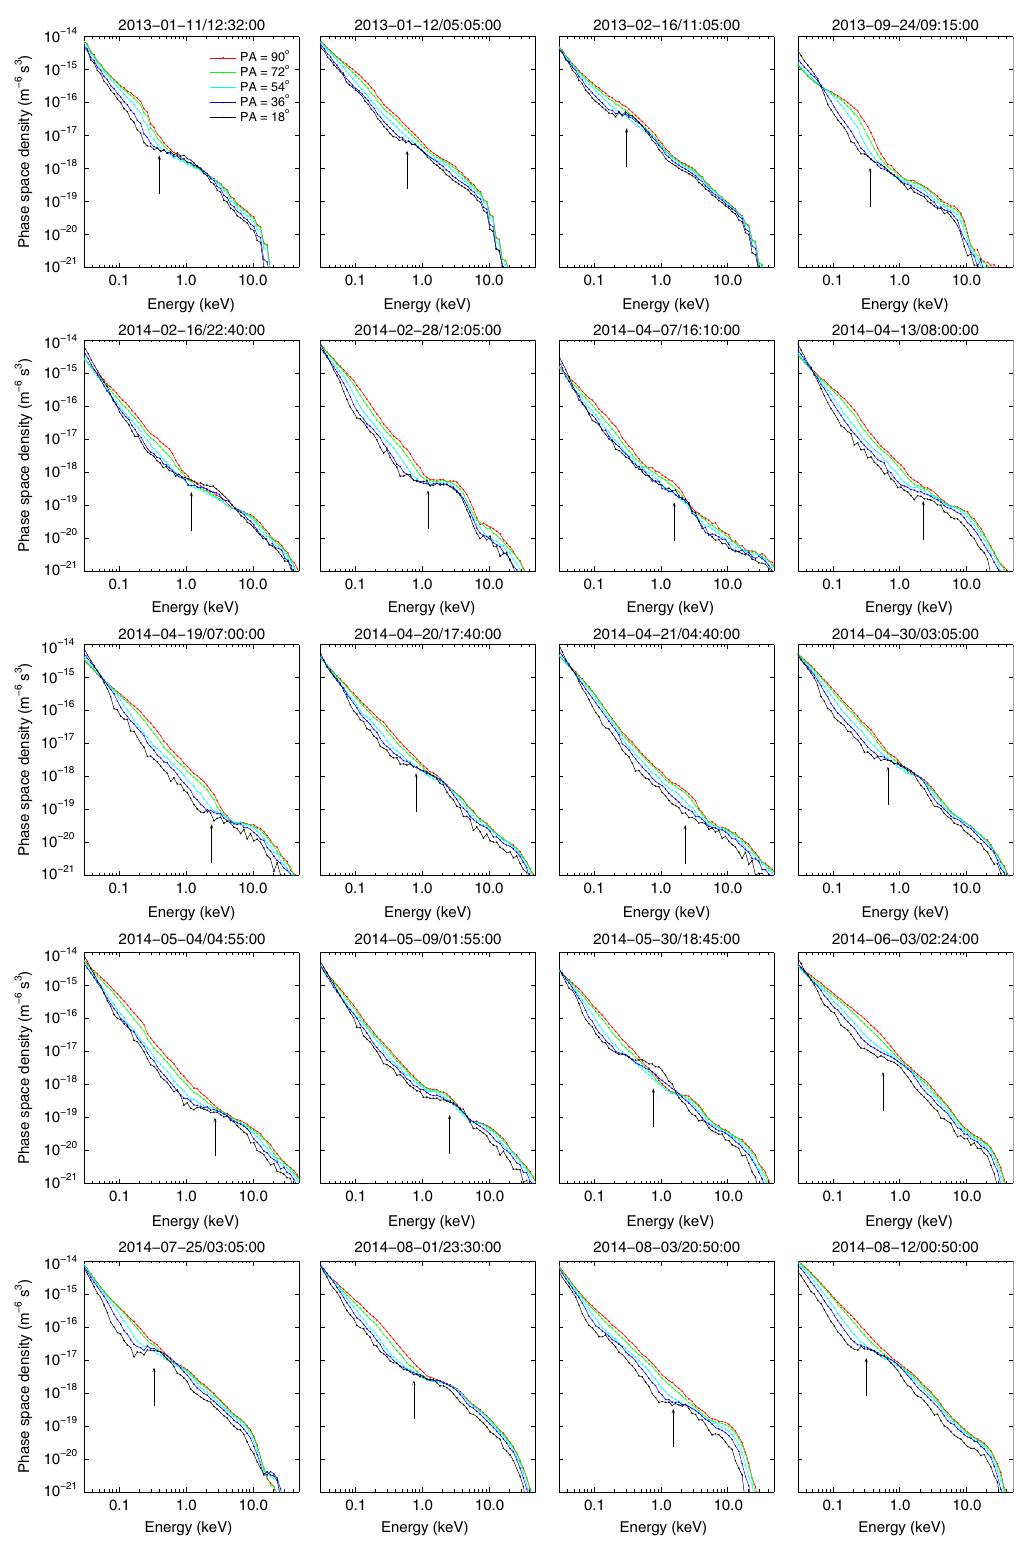
Fig. 3 Electron phase space densities during the 20 two-band chorus wave events. The arrows denote the representative equatorial Landau resonant energy. The color legends in Figure a are valid for the entire fi gure. Eighteen events show clear evidence of parallel acceleration at Landau resonant energies, identi fi ed by either electron parallel PSD plateau or that the PSD at 18° exceeds the PSD at 36° and even 54° pitch angles. The two exceptions are the 2014-04-19 and 2014-04-21 events where the parallel accelerations are not evident. However, all those 20 events show two anisotropic components separated by the Landau resonant